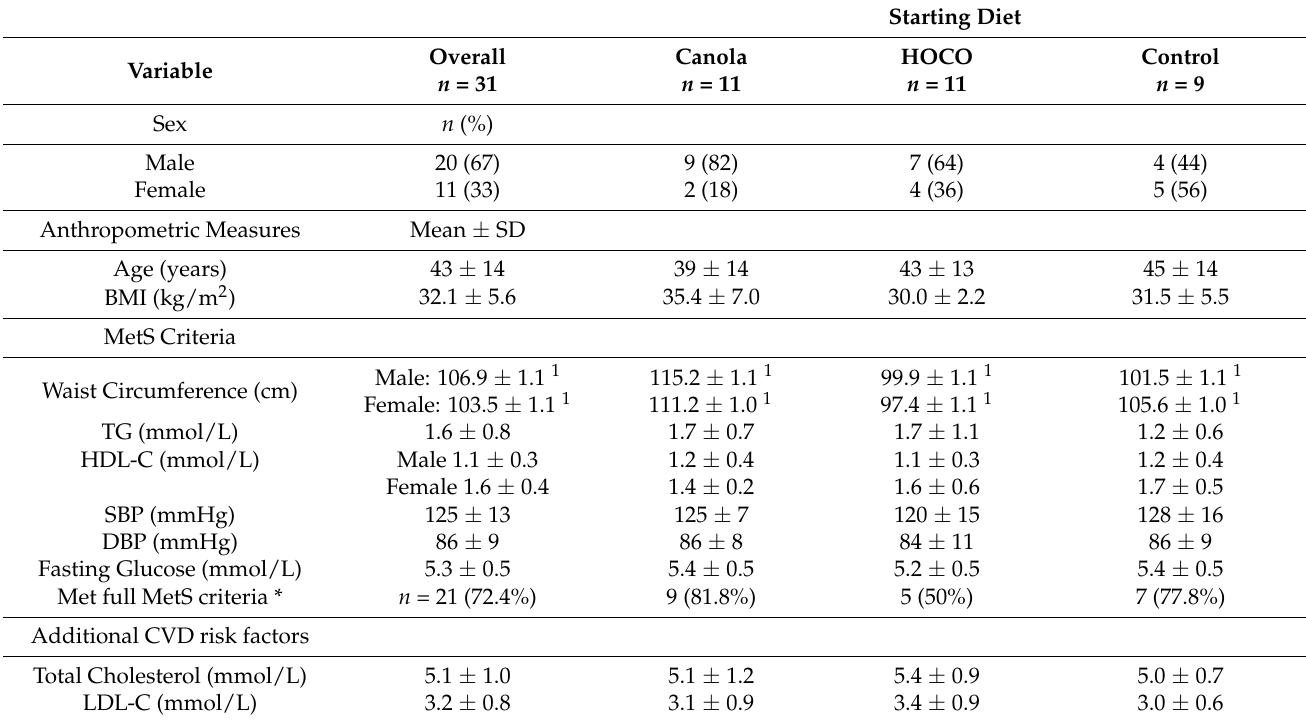
Table 2. Participant characteristics at baseline.